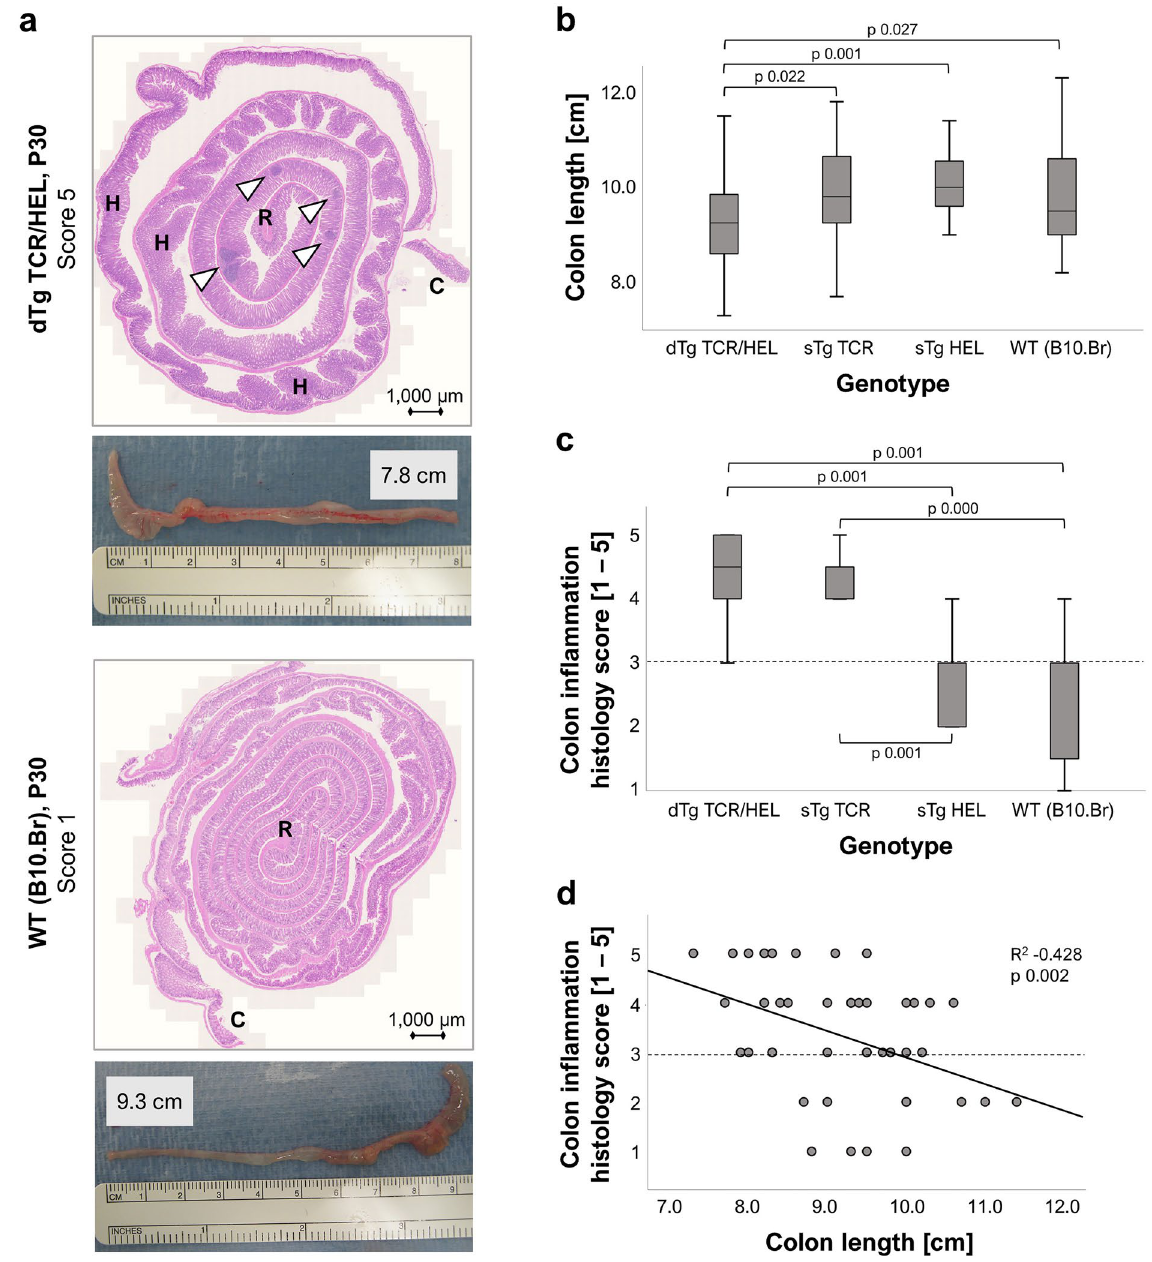
Figure 1. Mouse large intestines exhibit genotype-specific histological features. ( a ) H&E-stained colon section (Swiss roll) of dTg mice shows clear signs of inflammation (granulomatous colitis). Cardinal features are granulomas/crypt abscesses (white arrowheads) and crypt hyperplasia (H), along with bowel shortening and oedema. WT mice have longer bowels with normal appearance of mucosal epithelium. Abbreviations: R, rectum; C, caecum. ( b ) Colons of dTg mice are significantly shorter than those of all other genotypes; ( c ) Both dTg and sTg TCR colons have significantly more inflamed phenotypes as compared to the sTg HEL and WT mice. ( d ) Colon length and histological inflammation score are significantly correlated. Dashed lines indicate clinically irrelevant “background” colon inflammation. Non-parametric statistical procedures were used; significance scored at p ≤ 0.05. For each genotype group n = 10–13 colons were independently examined. Mice were aged P30 ± 3